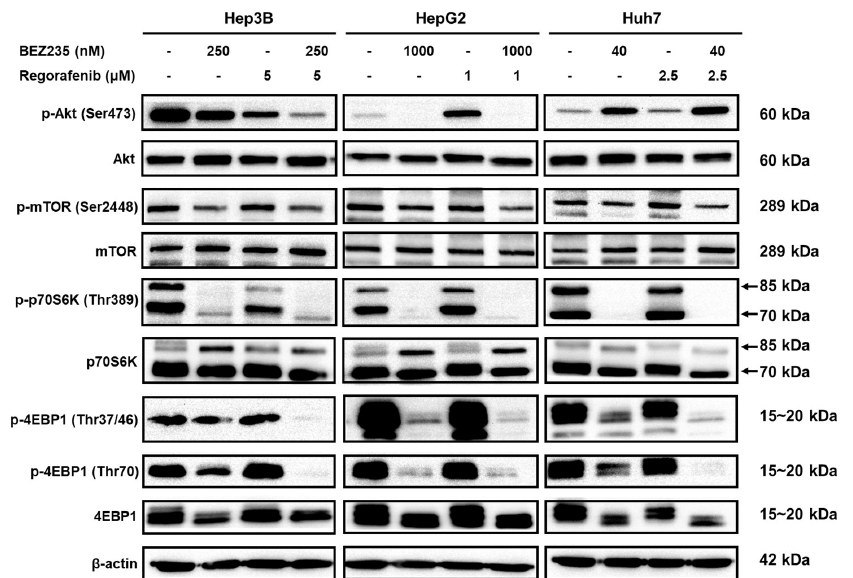
Figure 5. The combined treatment inhibits the activation of Akt/mTOR signaling pathway in the HCC cells. The panels indicate Western blot analysis for phosphorylation and total protein levels of the members of the Akt/mTOR pathway in the HCC cells treated with BEZ235 and regorafenib for 48 h.